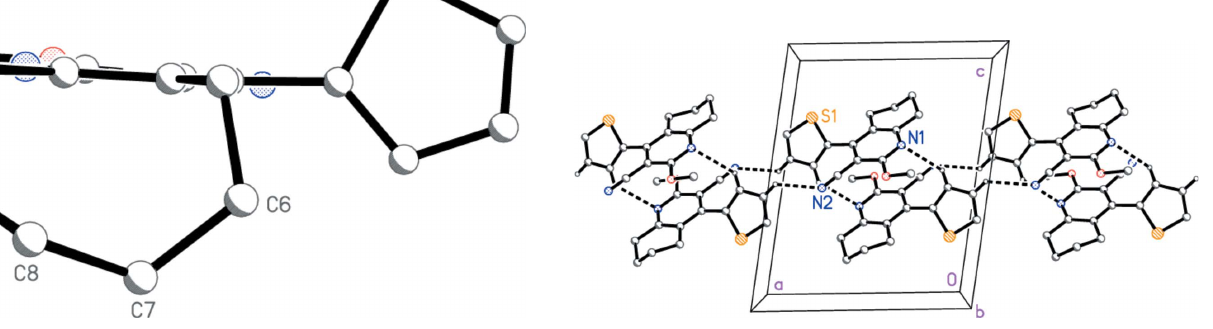
Figure 4 Side view of 1c (radii arbitrary, H atoms omitted). The labelled atoms are displaced from the plane of the pyridine-type ring B (for definition, see text) by 1.343 (2), 2.360 (2), 1.913 (2) and 1.395 (2) A˚ , respectively.